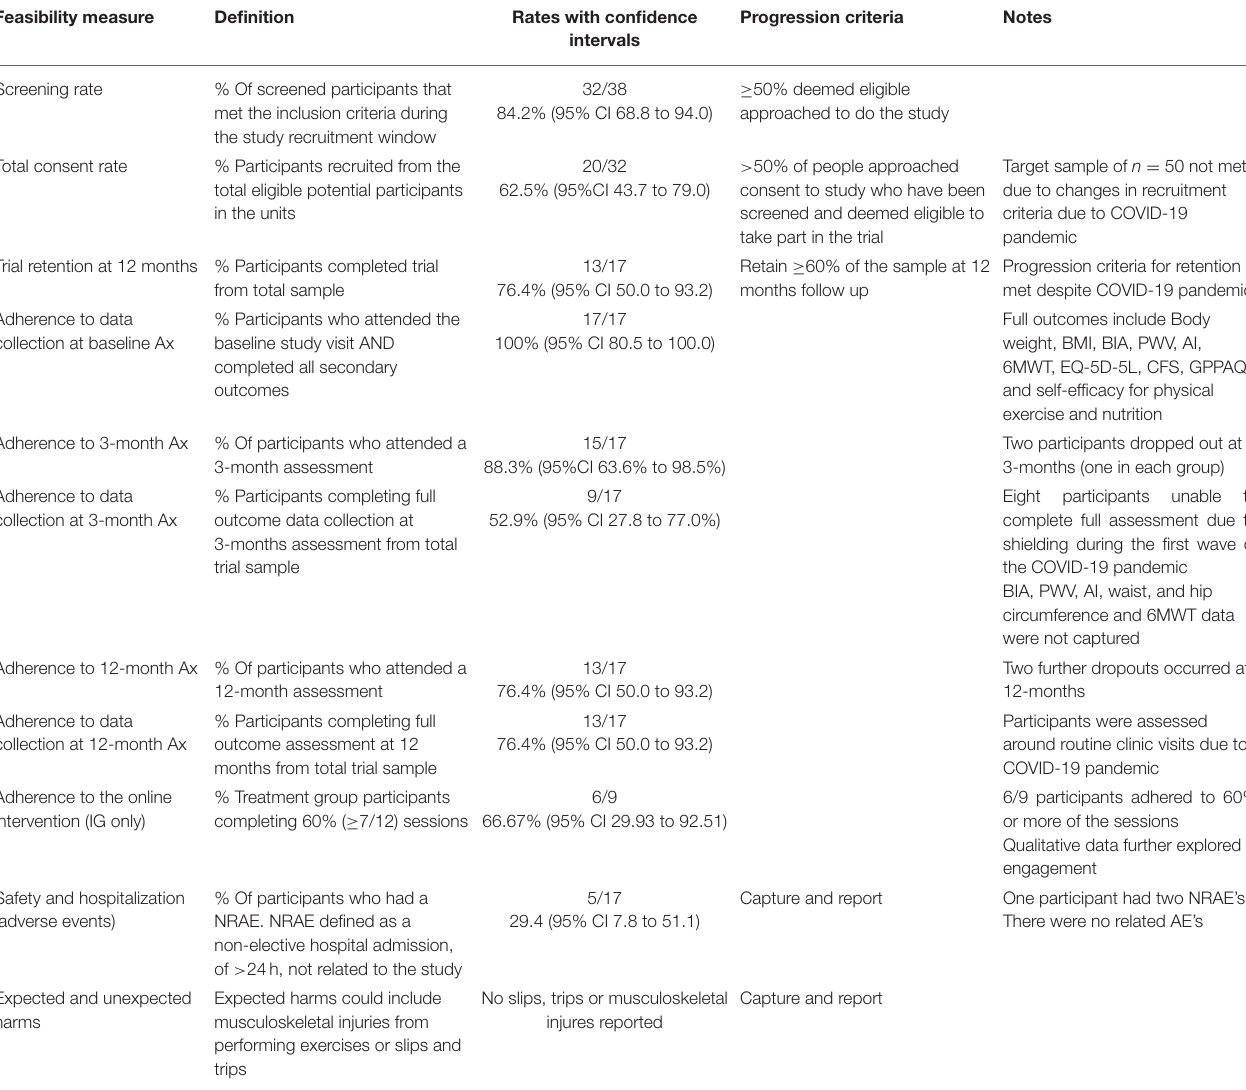
TABLE 5 | Mixed-methods results against feasibility outcomes and progression